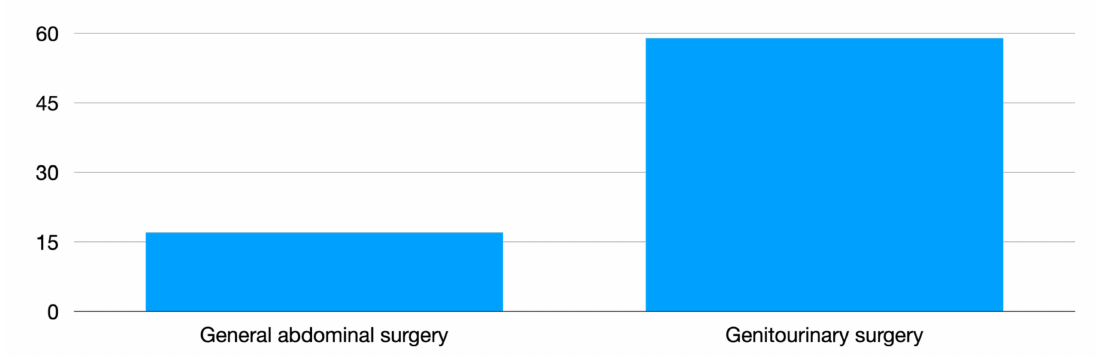
Figure 1. Number of surgeries by anatomical